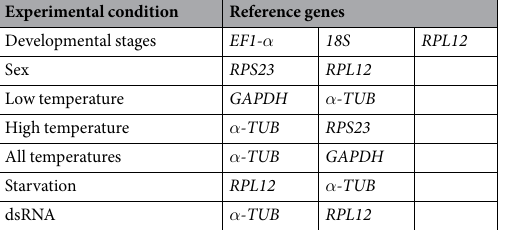
Table 3. Recommended reference genes according to the experimental condition.